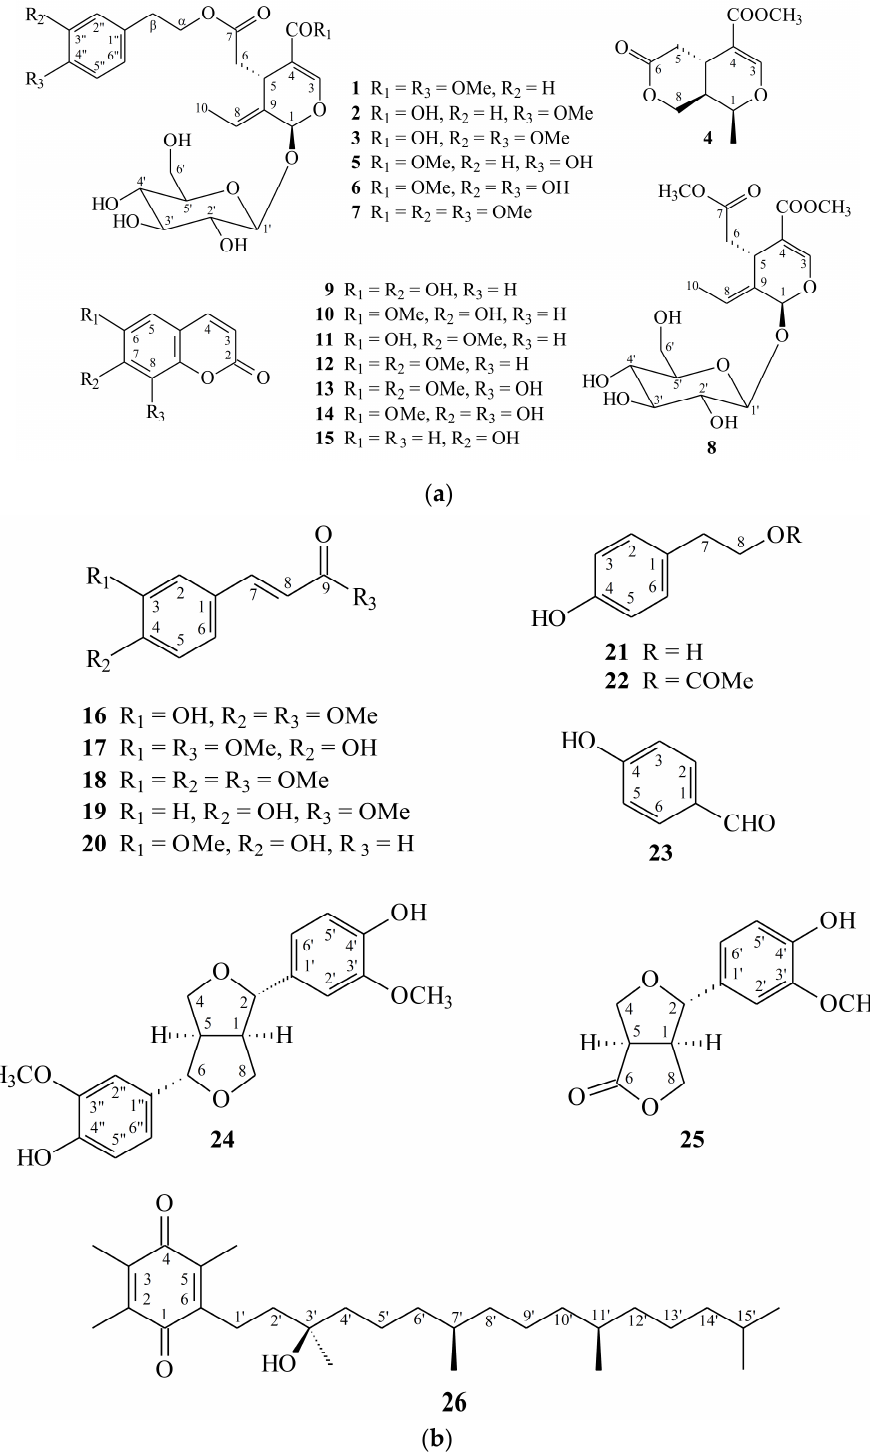
Figure 1. The chemical structures of compounds 1 – 15 ( a ) and 16 – 26 ( b ) isolated from F. chinensis.